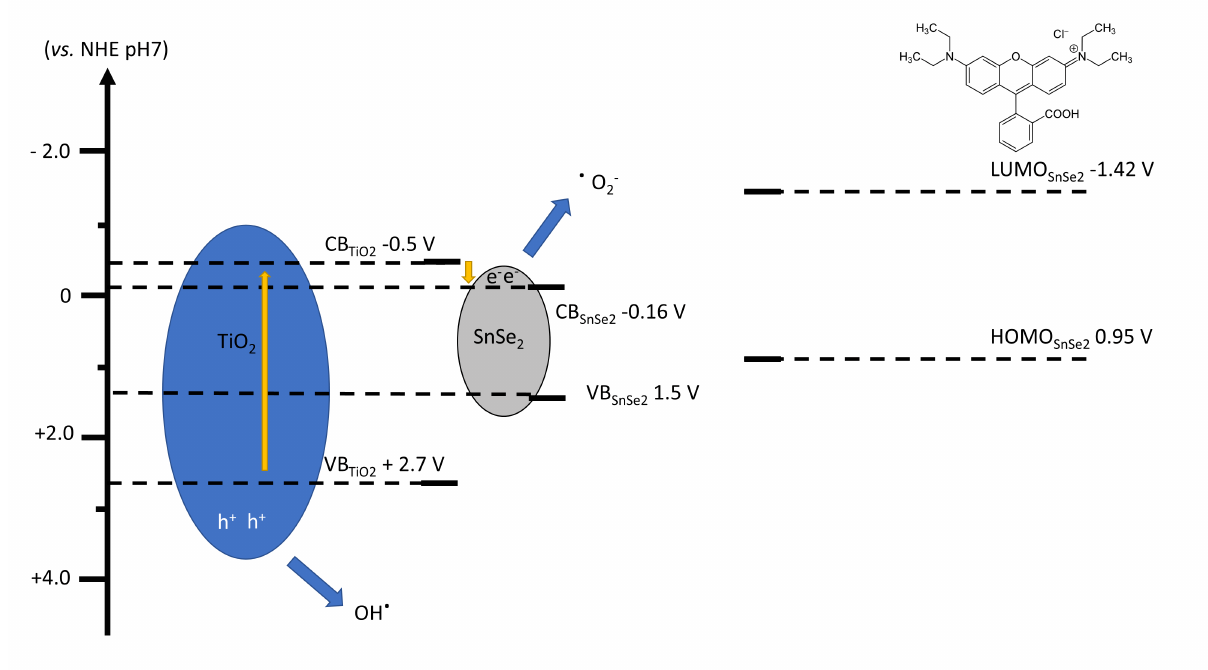
Figure 13. Hypothesis of the Rhodamine B degradation mechanism in presence of SnSe 2 nanoflakes under UV-Visible light. NHE, normal nitrogen electrode; CB, conduction band; VB, valence band; LUMO, lowest unoccupied molecular orbital; HOMO, highest unoccupied molecular